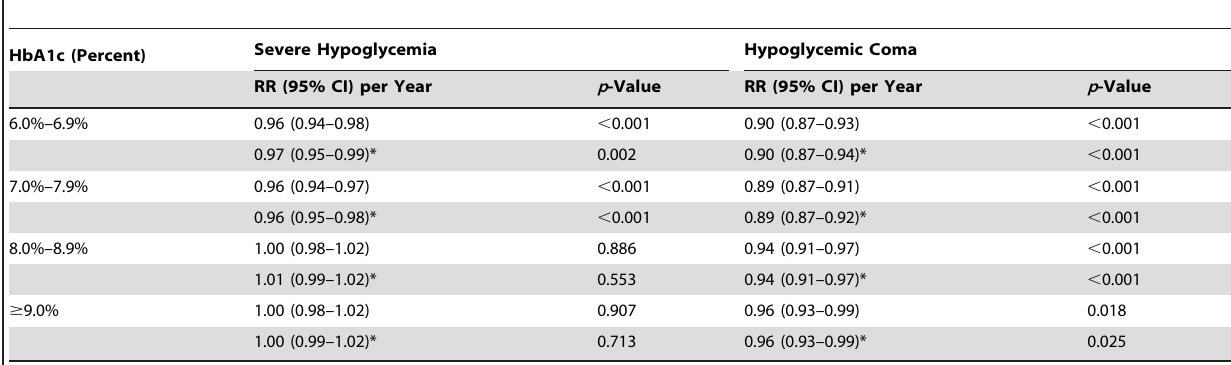
Table 3. Relative risk for severe hypoglycemia and hypoglycemic coma per year from 1995 to 2012 by HbA1c category.